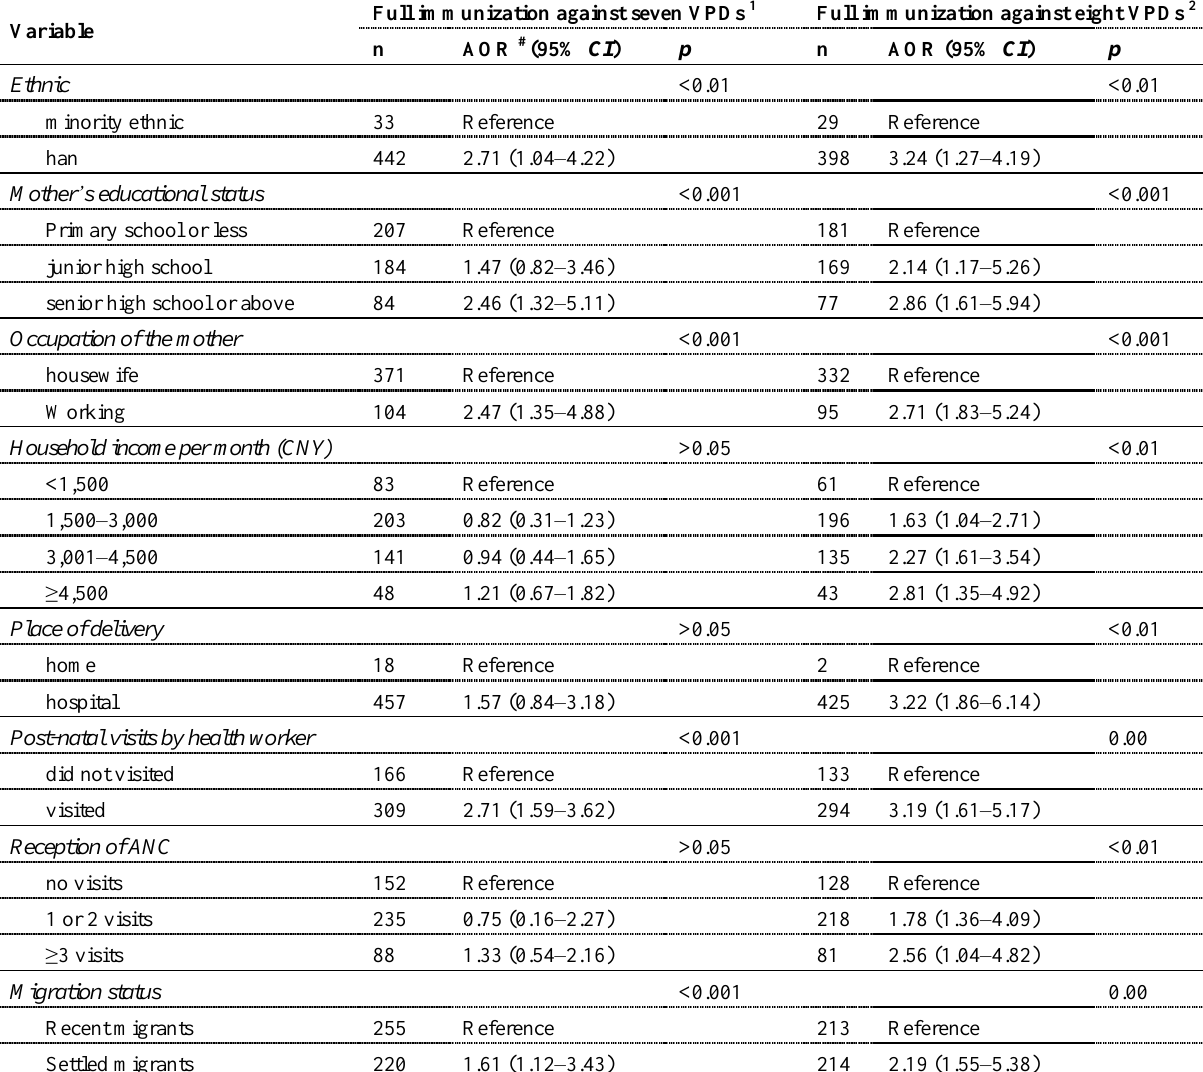
Table 3. Results of single logistic regressions showing the AORs of a child receiving full immunization by various